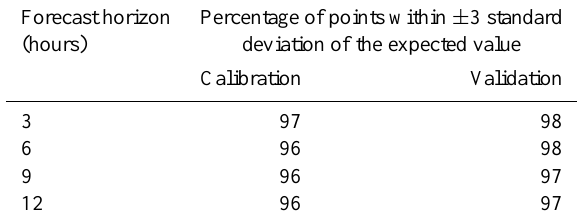
Table 2. Summary of the results of the DBM forecasts (gener- ated using observed rather than forecast precipitation) for multiple lead